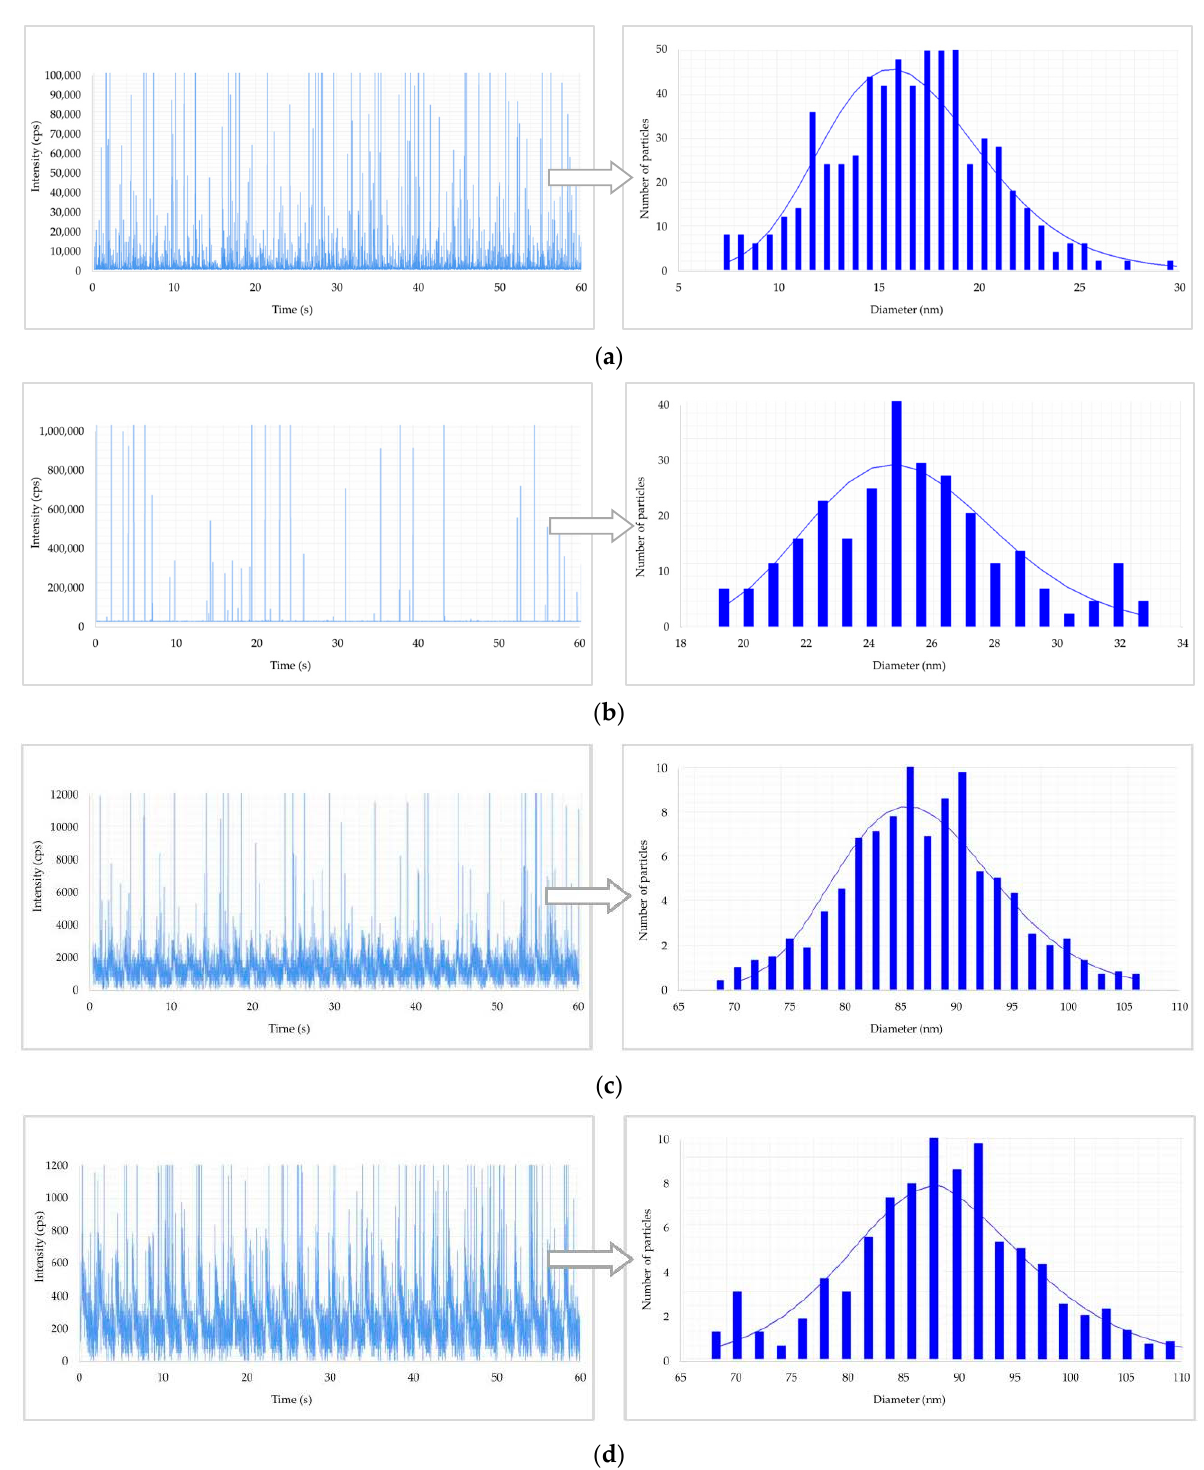
Figure 3. Results of metal nanoparticles (NPs) found in blood of a worker: ( a ) raw data and particle size distribution (PSD) of Au NPs at the post shift end of week; ( b ) raw data and PSD of In NPs at the post shift end of week; ( c ) raw data and PSD of Ti NPs at the post shift end of week; ( d ) raw data and PSD of Ti NPs in a control worker.